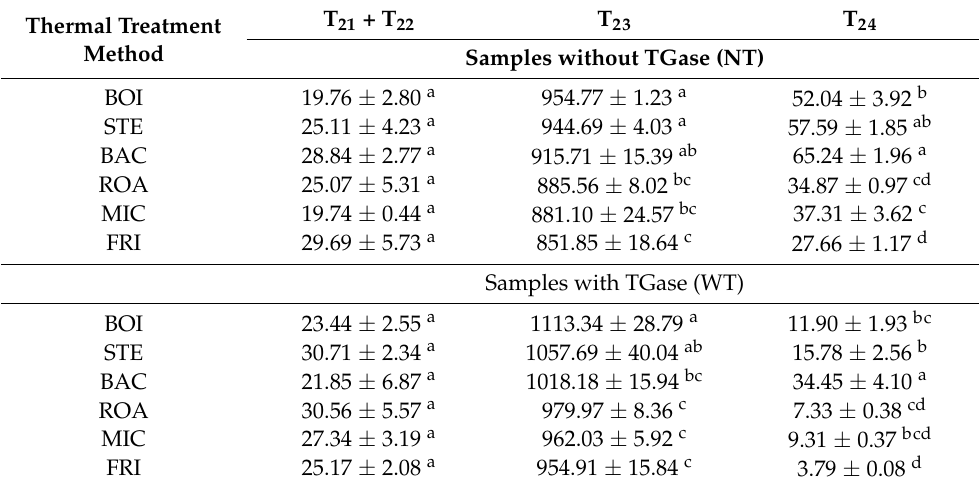
Table 2. Spectral peak areas of various water states in D. maruadsi surimi